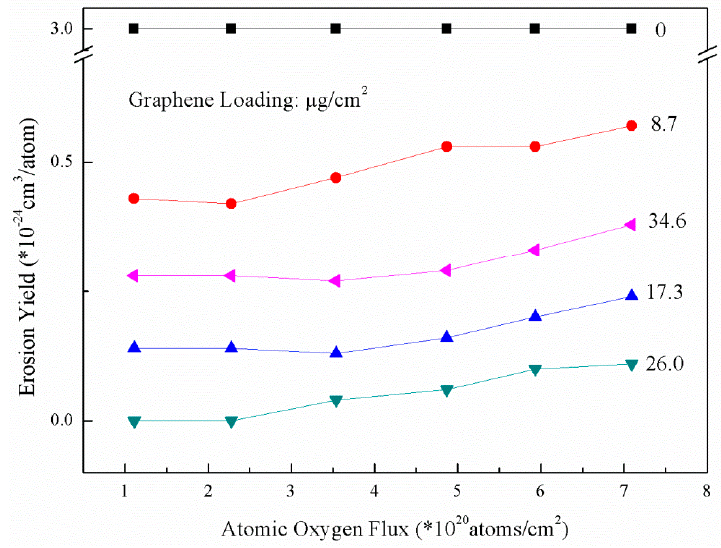
Figure 9. AO erosion yield of coated Kapton with different graphene loadings.